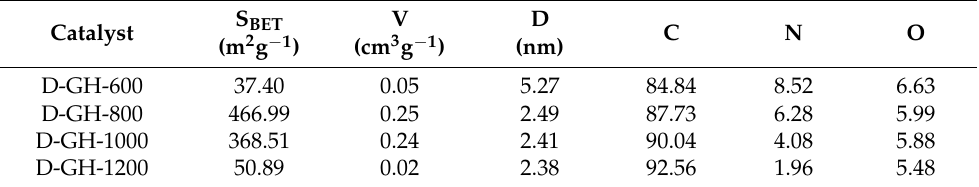
Table 1. Pore structure parameters and element content of various catalysts.